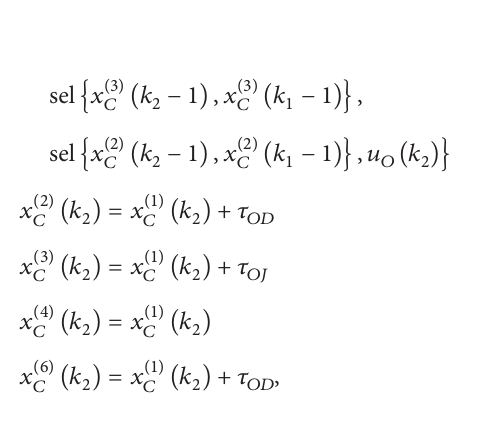
Figure 9: Type II protection-zone conflict-control